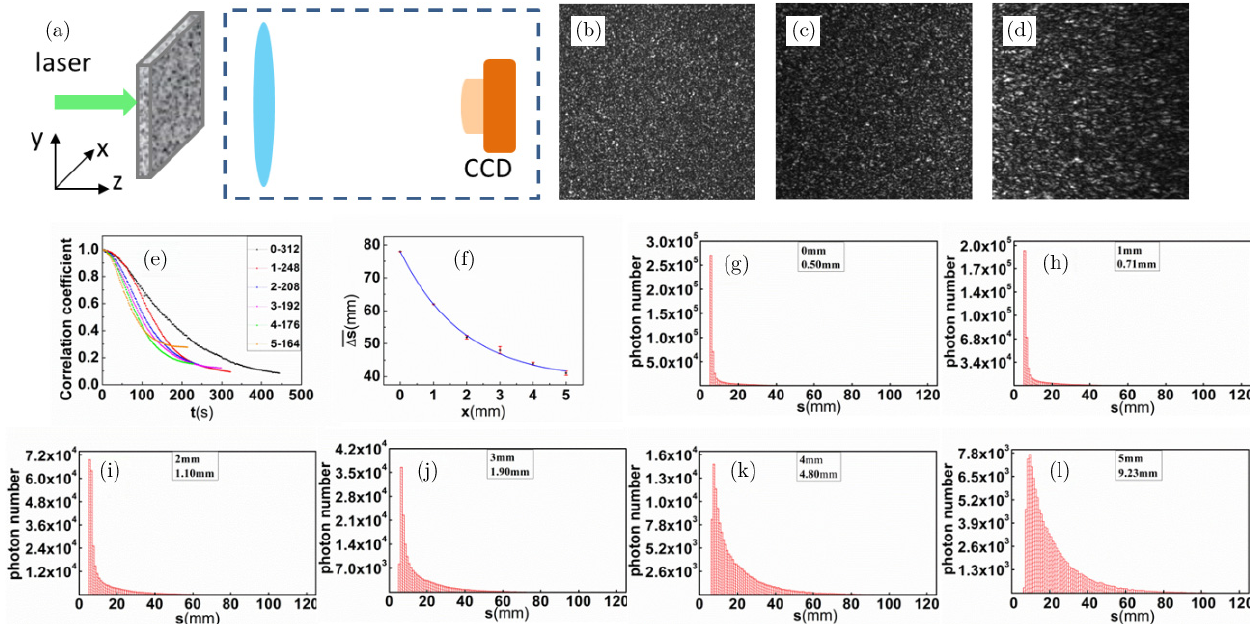
Fig. 1. The relationship between decorrelation time and di®erent scattering components. (a) Experiment setup, the back surface of the gelatin layer is imaged onto the CCD with a magni¯cation factor of 5. (b) – (d) are corresponding speckle patterns achieved at x ¼ 0, 3 and 5mm, respectively. (e) The temporal autocorrelation curves at di®erent locations, the inserted legend is presented in a manner of \line type-location x -decorrelation time". (f) The relationship between decorrelation time and location x . (g) – (l) path length histograms at x ¼ 0, 1, 2, 3, 4 and 5 mm, respectively, where in each inserted legend, the location x and the corresponding FWHM are presented.